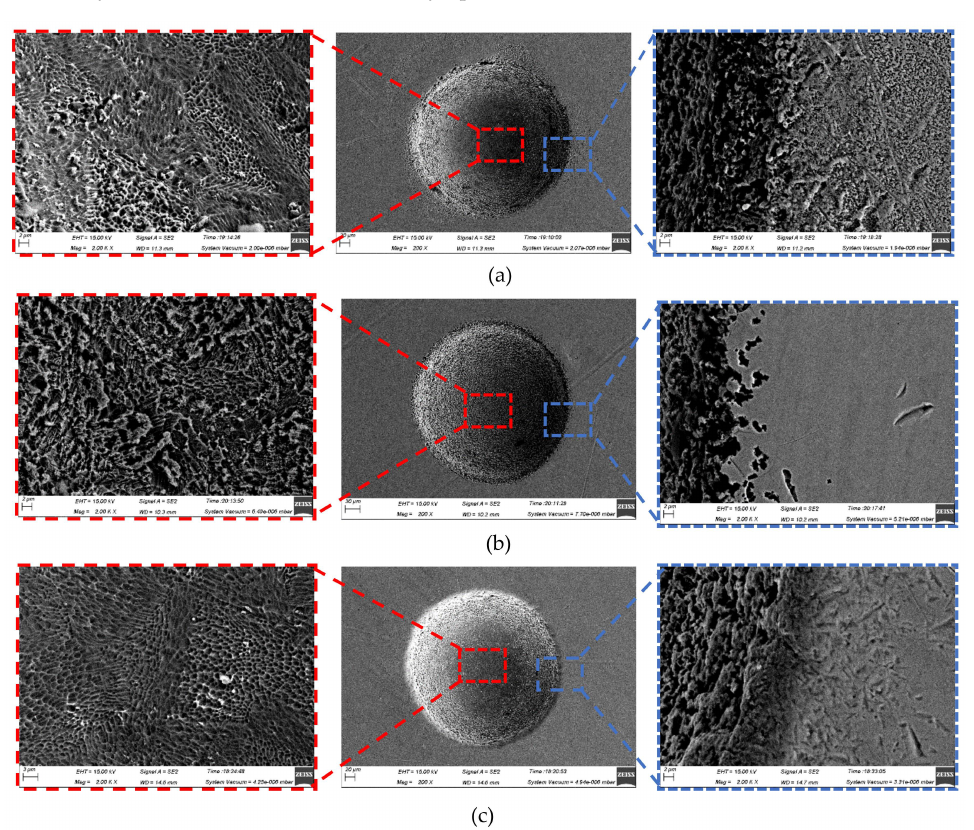
Figure 8. Scanning electron microscope (SEM) images of the micro-dimples machined with di ff erent modes when the electrical voltage was 10 V, the nozzle’s inner diameter was 170 µ m, and the working gap was 100 µ m. ( a ) Vertically downstream mode; ( b ) vertically upstream mode; ( c ) horizontal